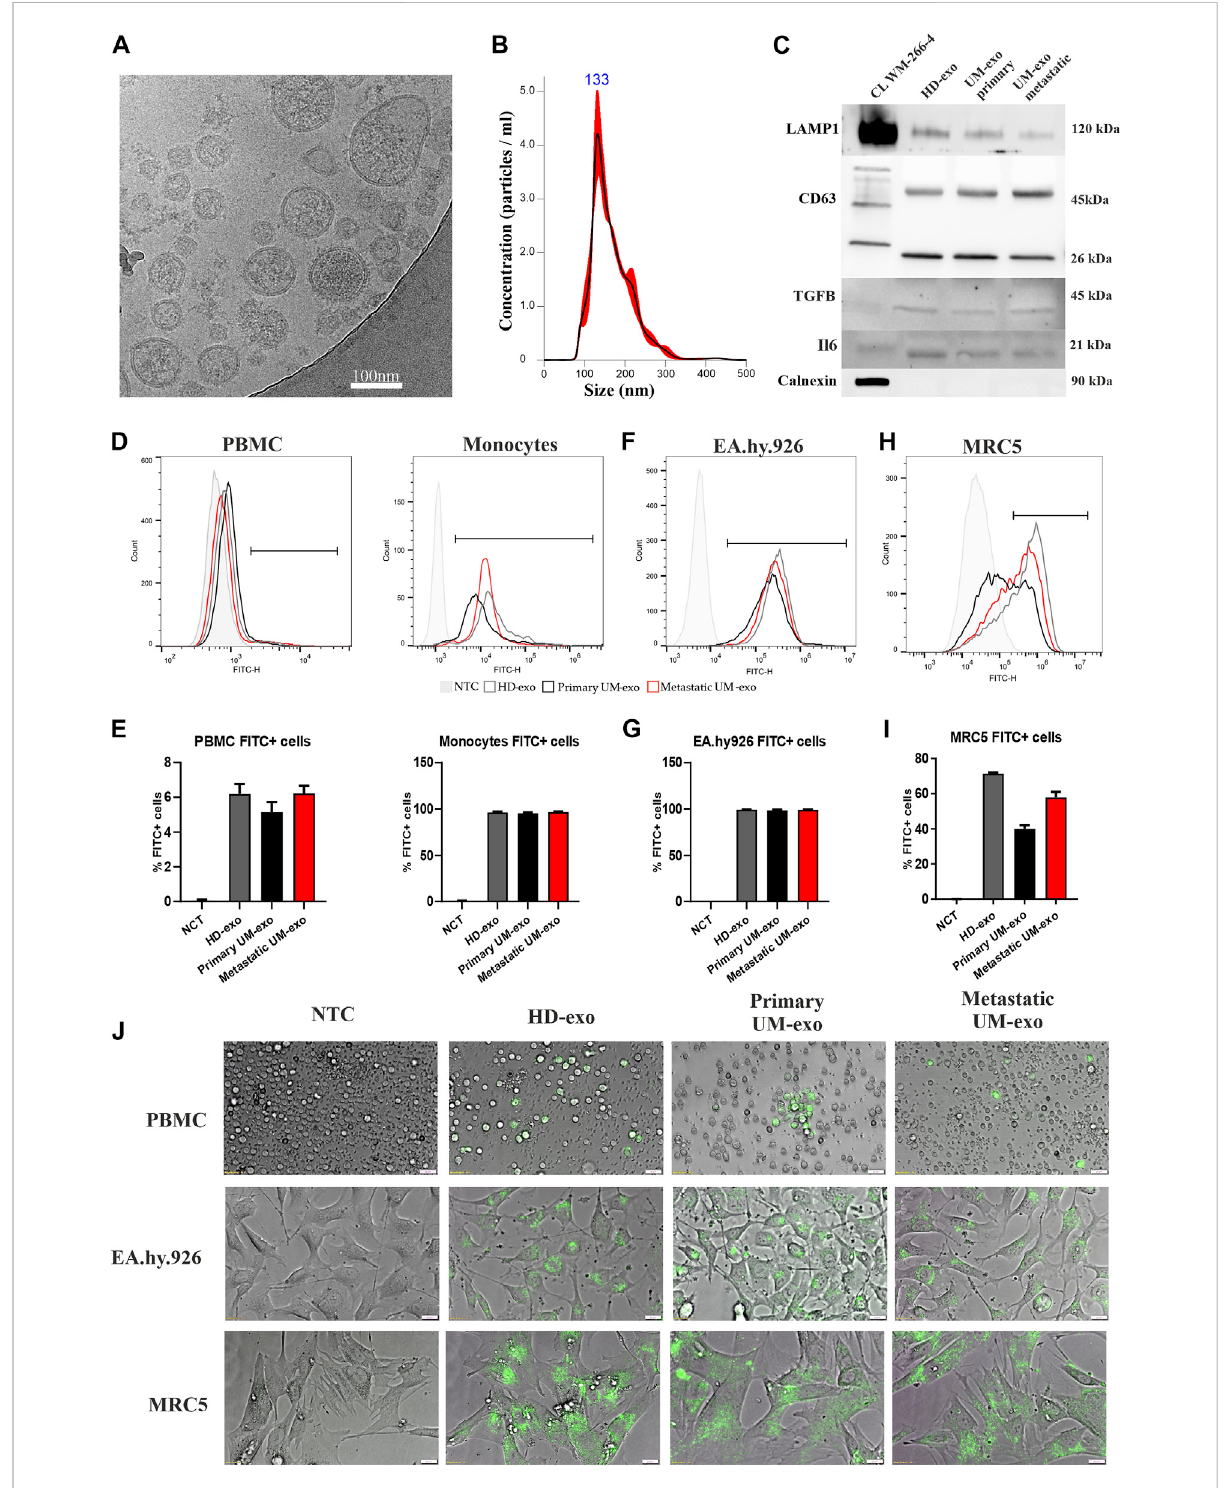
The analysis of exosomes isolated from the serum of uveal melanoma patients with primary and metastatic disease (UM-exo primary and UM- exo metastatic), and healthy donors (HD-exo). The cryogenic electron microscopy showed proper shape and structure of EVs (A) . The size distributionofisolatedvesicleswasrangingbetween50and200 nm (B) .TheexpressionofproteinmarkersofEVs(LAMP1,CD63),theirproteincargo (TGFB1, IL6 and absence of organelle-speci fi c proteins (Calnexin) was con fi rmed by western blot. (C) . The fl ow cytometric analysis of uptake